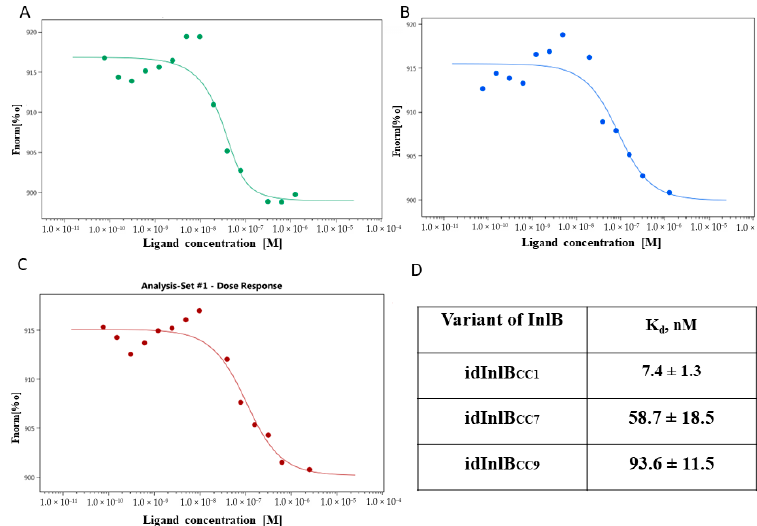
Figure 1. MST binding curves of idInlB CC1 ( A ), idInlB CC7 ( B ) and idInlB CC9 ( C ) with c-Met. The c-Met were titrated against fluorescent labeled 50 nM idInlB variants. The normalized thermophoresis value Fnorm% was plotted against the c-Met concentration. Data of one from three independent measurements are shown. ( D ) Mean values of dissociation constants (K d ) ± standard deviation for human c-Met binding with InlB variants from three independent experiments. Next, dissociation constants for the alternative InlB receptor, gC1qR, were analyzed. The human gC1qR was titrated in a concentration range from 0.076 nM to 2.5 μ M against fluorescent-labeled 50 nM isoforms of InlB. The normalized thermophoresis value Fnorm Int. J. Mol. Sci. 2023 , 24 , x FOR PEER REVIEW % was plotted against the idInlB CC1 , idInlB CC7 , and idInlB CC9 concentration fitted to a 1:1 binding model resulting in a dissociation constant Kd = 7.4 ± 0.8 nM, 10.2 ± 0.9 nM, and 21.5 ± 1.0 nM, respectively (Figure 2A–D). These data showed that three variants bound the receptor, but idInlB CC9 bound it three times weaker than idInlB CC1 and it two times weaker than idInlB CC7 . There was no significant difference in binding strength between the idInlB CC1 and idInlB CC7 isoforms for gC1qR. Note that the binding curves of idInlBs with gC1qR and with c-Met have opposite forms. The microscale thermophoresis method is based on changes in fluorescence of the ligand stained with the fluorescent dye. Upon receptor binding, fluorescence of the ligand can increase or decrease in dependence on a receptor and a buffer composition. If the ligand–receptor interactions increase fluores- cence, the curve is rising; if these interactions decrease fluorescence, the curve is descend- ing. The calculation of the Kd values is determined from the shape of the curve and does not depend on its direction [44].